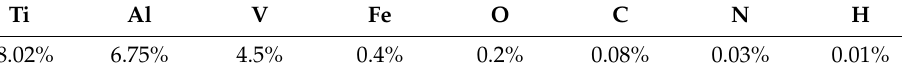
Table 1. Chemical composition of Ti-6Al-4V (wt.%).